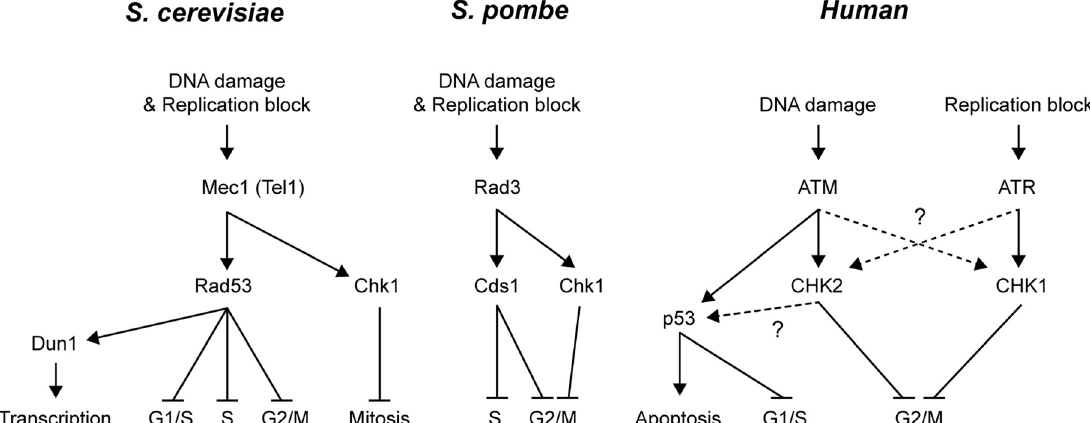
Figure 2 - Schematic representation of the signaling network of DDR kinases in yeast and human. In S. cerevisiae , DNA damage and replication block signal is preferentially transduced from Mec1 to Rad53 and Chk1 with Tel1 showing an overlap with Mec1. Rad53 inhibits the G1/S, S phase and G2/M cell cycle transitions and activates transcription in a Dun1-dependent manner. Chk1 acts in parallel to Rad53 inhibiting mitosis by preventing anaphase entry. In S. pombe , DNA damage and replication block signal is preferentially transduced from Rad3 to Cds1 and Chk1. Cds1 inhibits S phase and rein- forcesG2/MinhibitiontogetherwithChk1.Inmammaliancells,ATMsignalstop53,whichinturnactivatesapoptosisandinhibitsG1/Scellcycletransi- tion (Kastan et al. , 1991; Lowe et al. , 1993). While ATM signals to CHK2, ATR signals to CHK1 in response to DNA replication inhibition. Both CHK1 and CHK2 inhibit the G2/M cell cycle transition, although at that time their roles during S phase progression were unknown. Also, there was still no evi- dence on the crosstalk between ATM/ATR with CHK1/CHK2, nor between CHK2 and p53. Dashed lines and interrogation marks represent unknown pathways at that